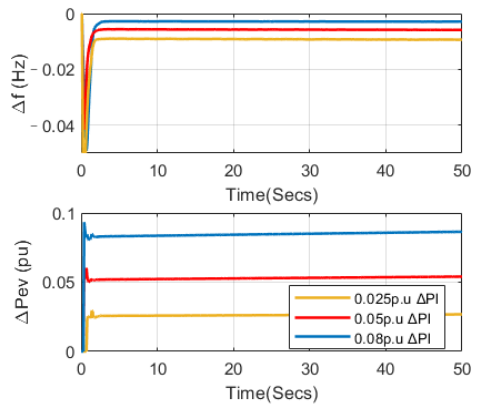
Figure 13. Dynamic response of the system under different load disturbances.